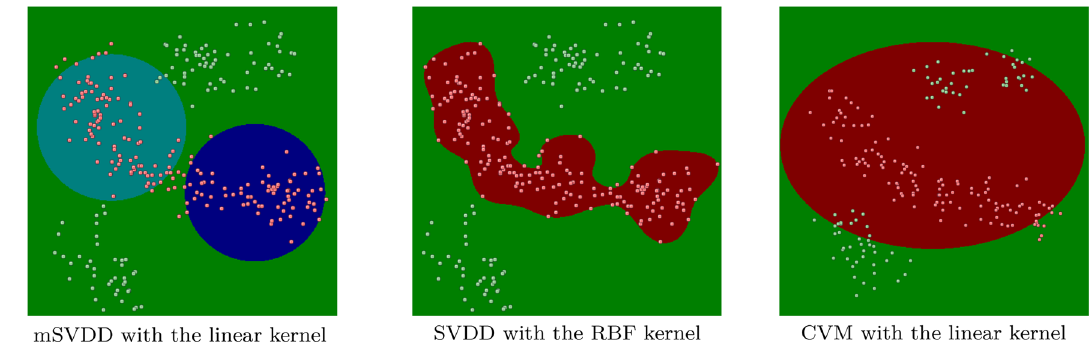
Fig. 4 Comparison of mSVDD with the linear kernel, SVDD with the RBF kernel, and CVM with the linear kernel